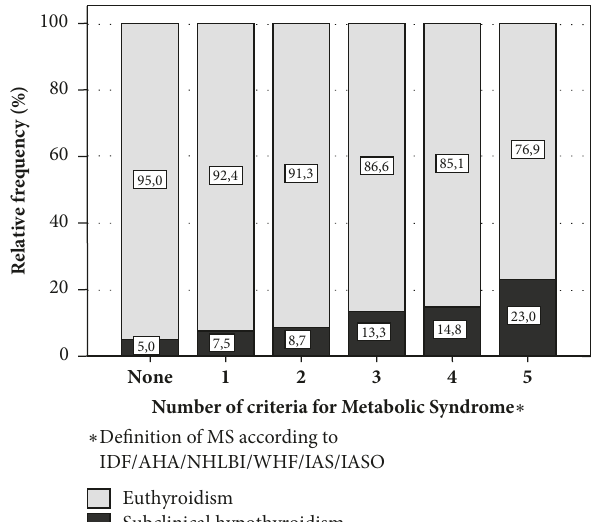
Figure 2: Subclinical hypothyroidism and number of criteria for Metabolic Syndrome in adults from Maracaibo City,